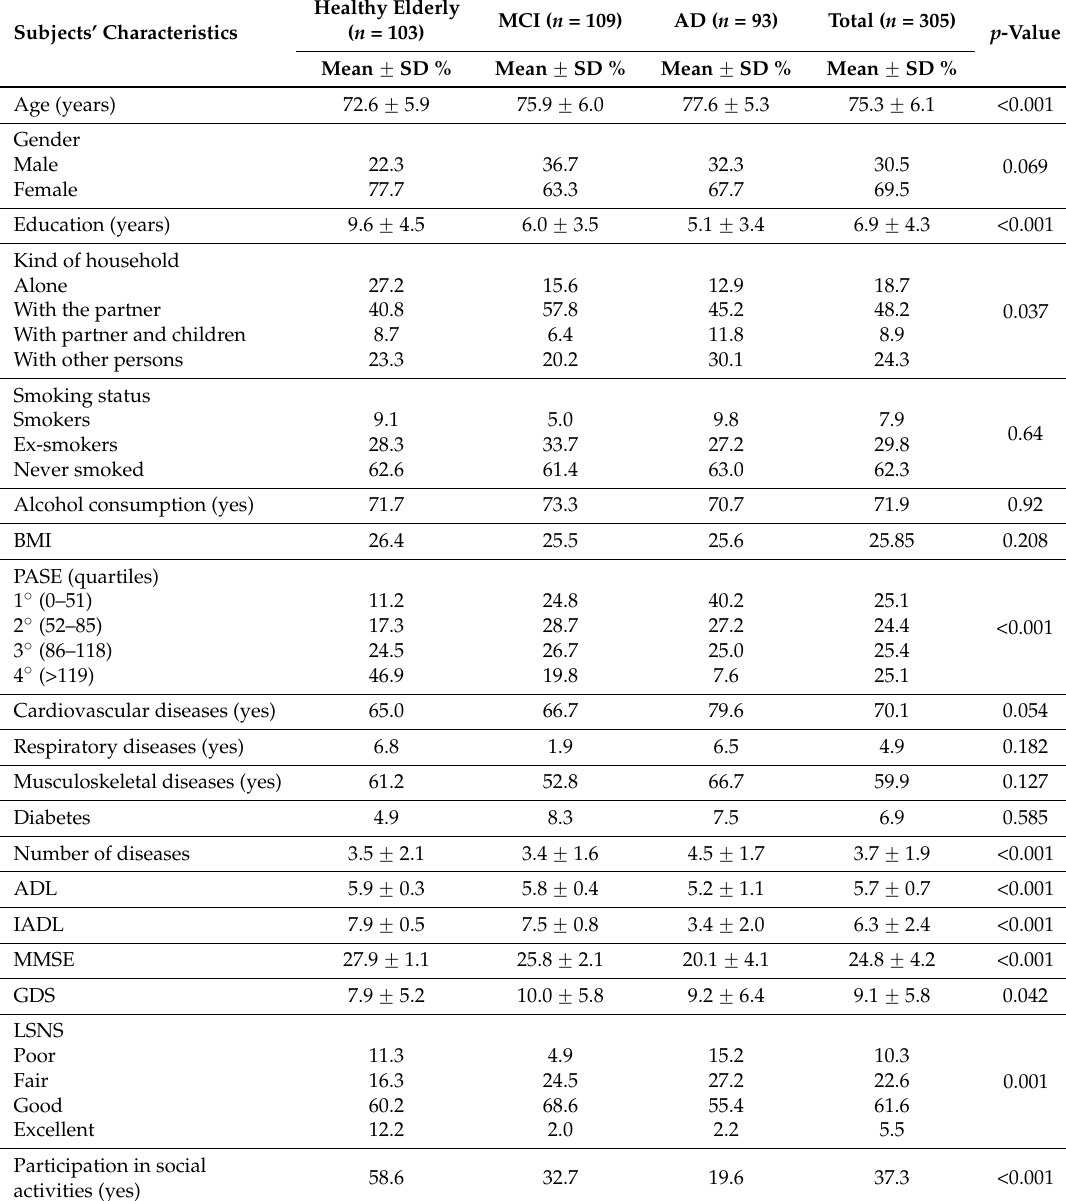
Table 1. Characteristics of the subjects by